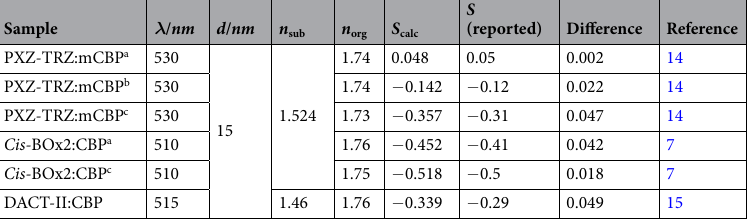
Table 2. Comparison of S calc and reported S values. Vapour deposition at a 300 K, b 250 K, and c 200